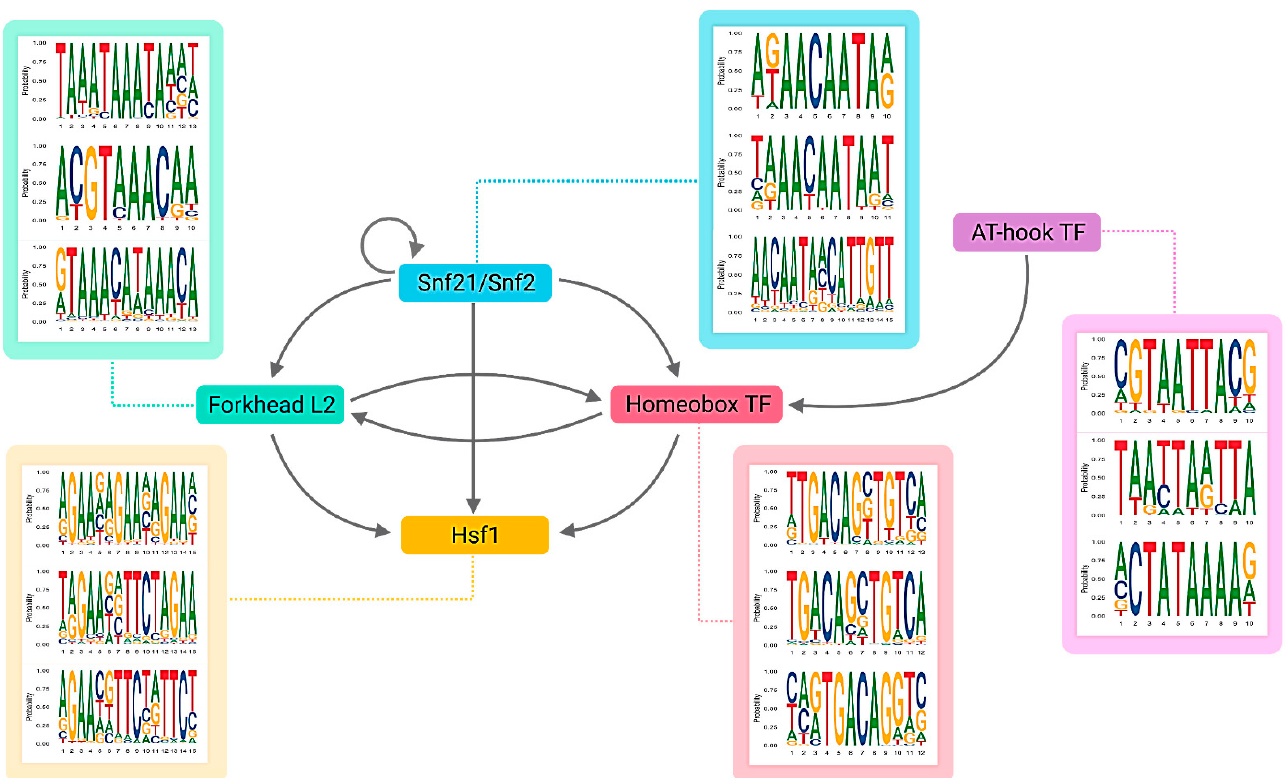
Figure 4. The regulatory sub-network of five key TFs including Snf21 (CCM_04586), a forkhead box protein L2 (CCM_02646), a homeobox TF (CCM_07504), Hsf1 (CCM_05142) and an AT-hook DNA-binding TF (CCM_08536). The figure also shows the examples of the DNA-binding domains for each TF predicted by RSAT.